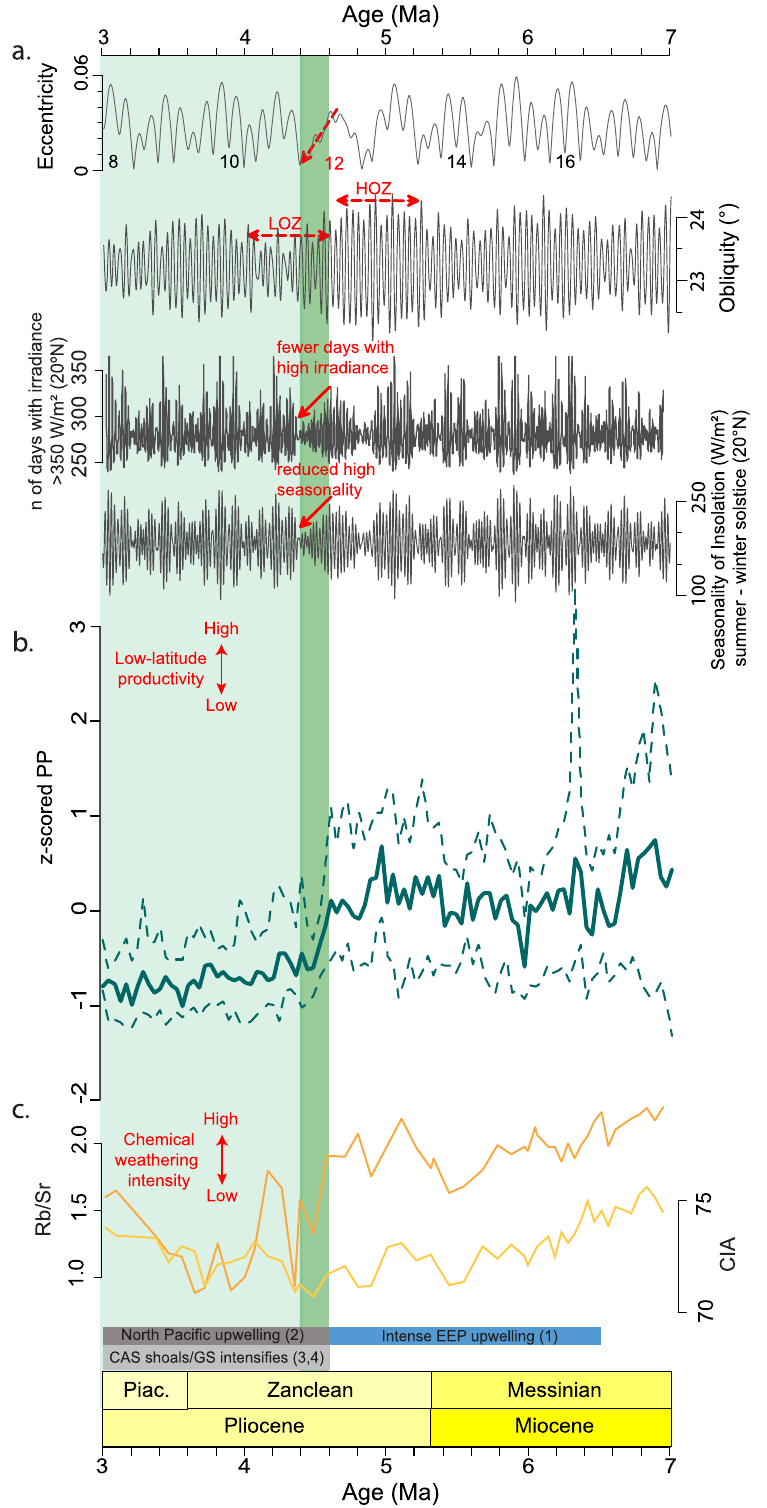
that high-resolution fossil plankton assemblage studies may